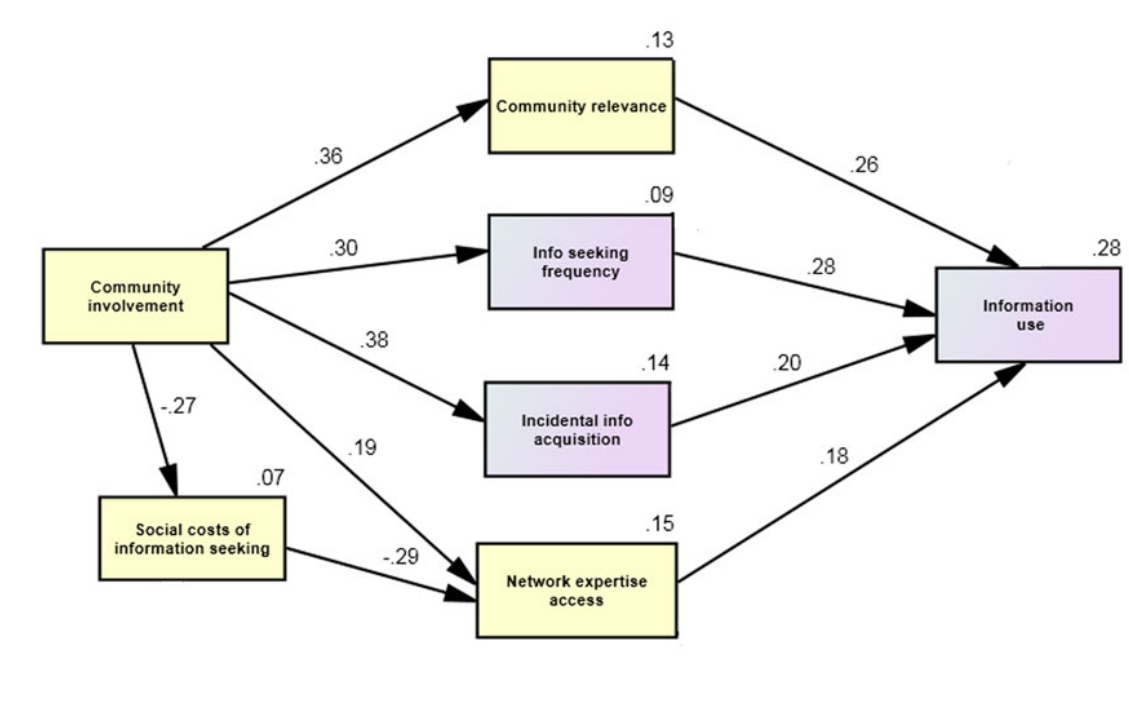
Figure 1. Model of community involvement factors in human-information